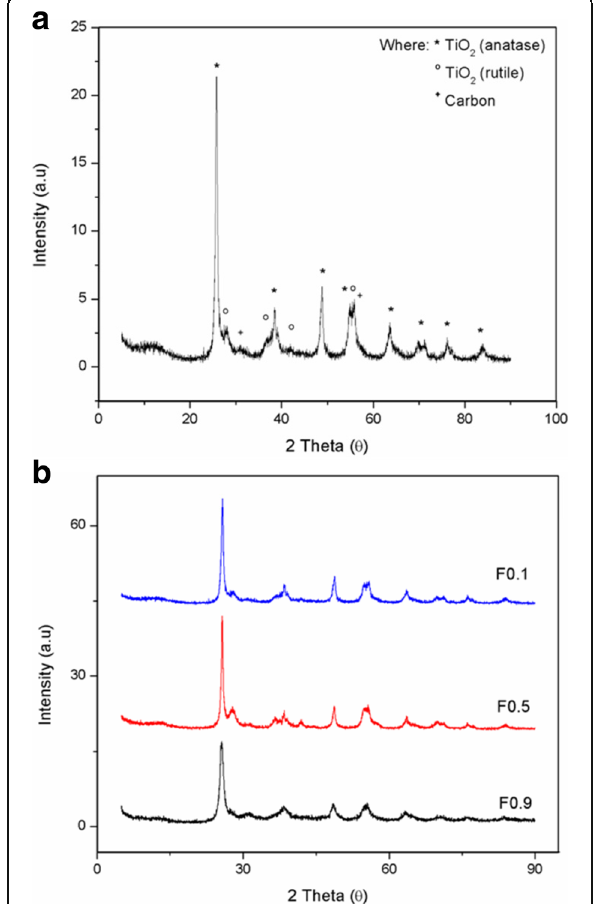
Fig. 2 The IR spectrums for the TiO 2 -CNF sample with different flow rate parameter at the range of 650 to 4000 cm − 1 wavenumber